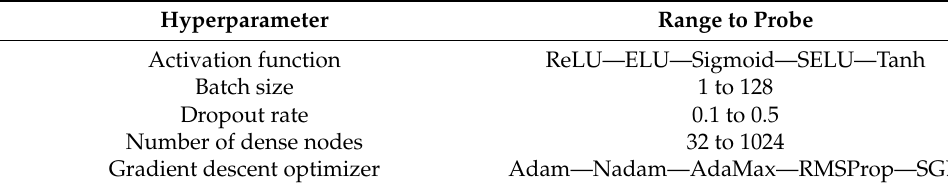
Table 2. Hyperparameters setting.